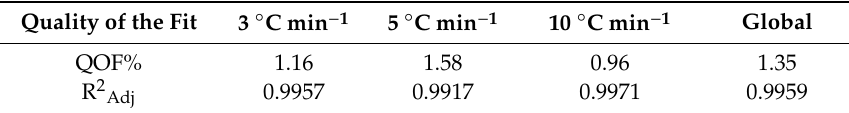
Table 10. Quality of the fit for each